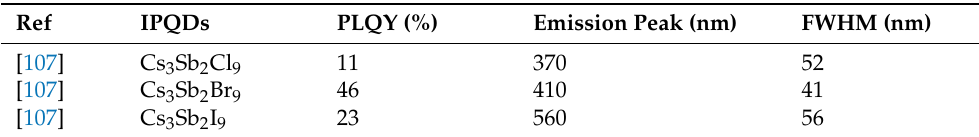
Table 6. Summary of PLQY and emission peaks for colloidal Cs 3 Sb 2 X 9 IPQDs Copyright 2017, American Chemical